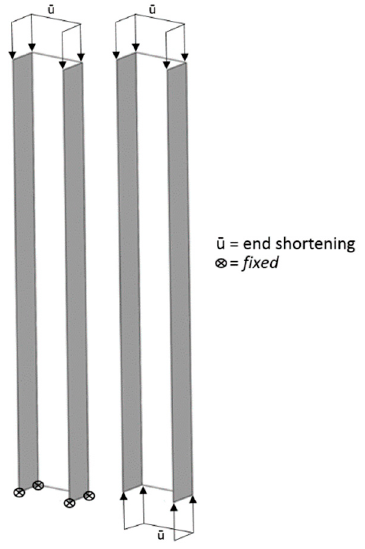
Figure 1. Forms of different loading conditions.